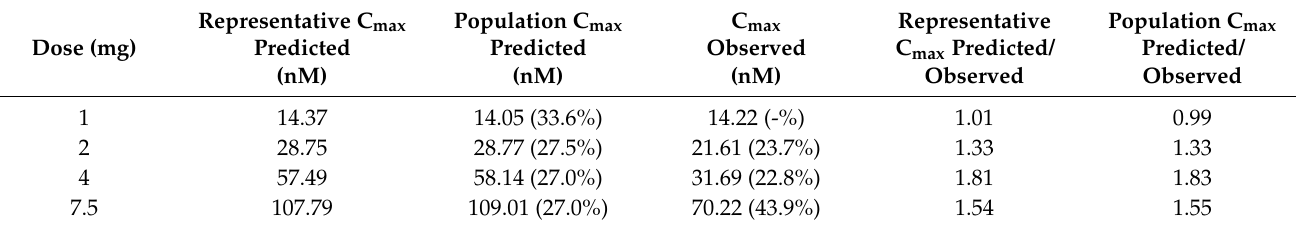
Table 2. Comparison of predicted vs. observed C max for siremadlin. Population representative and total population- derived C max parameters were generated via first-order absorption mechanism and are presented as geometric means